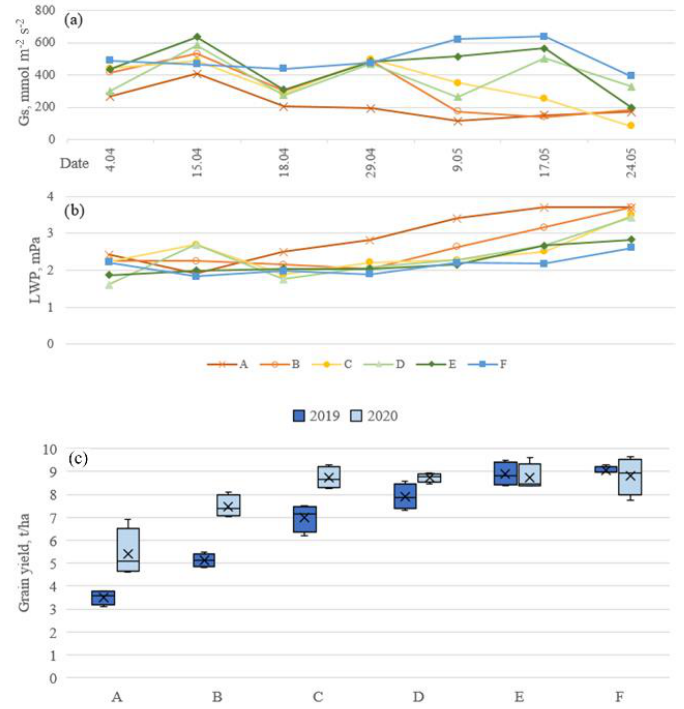
Figure 4. ( a ) Stomatal conductance (g s ) for April–May 2019, ( b ) leaf water potential (LWP) for April–